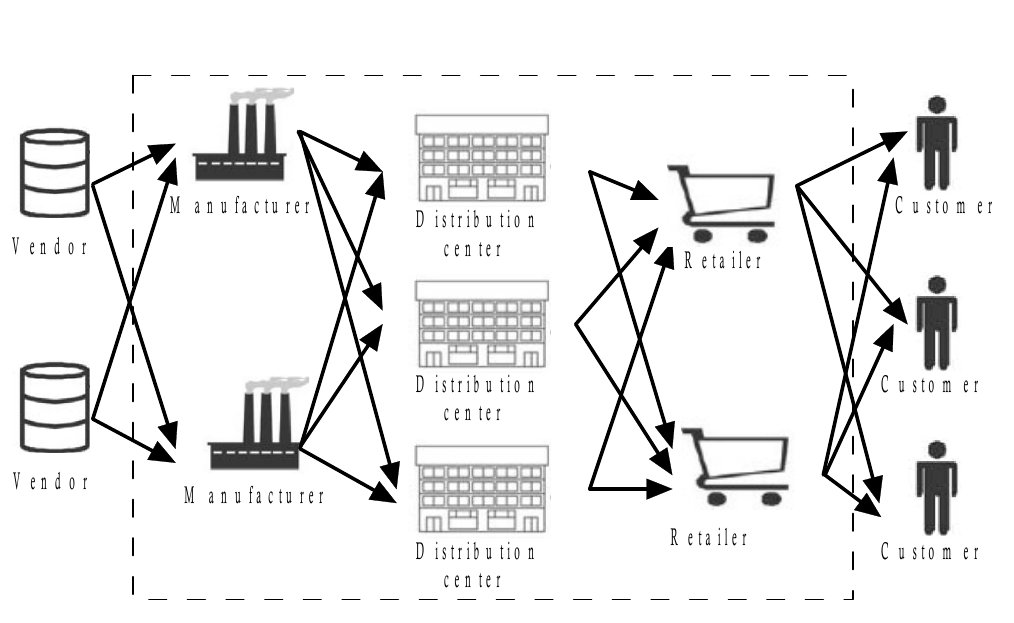
Figure 1. The schema of supply